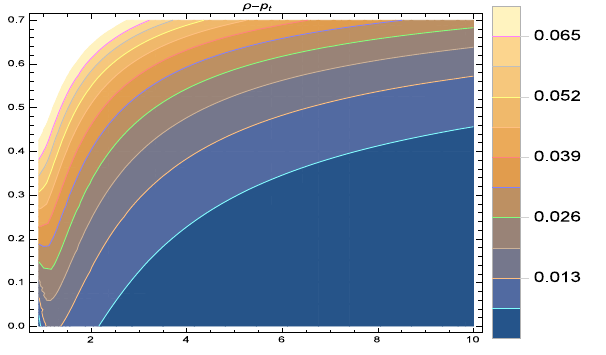
Fig. 6 ρ − p t for Case-I (left) and Case-II